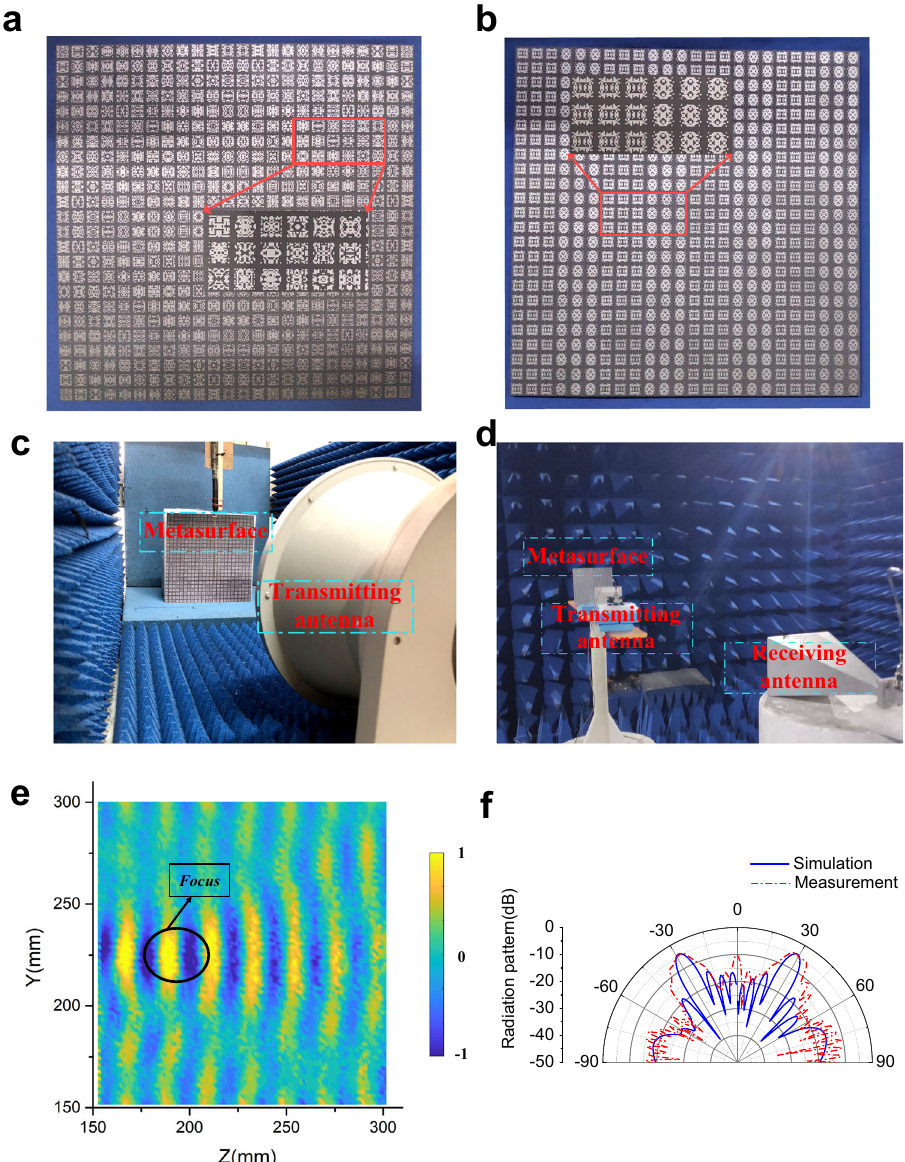
Fig. 6 Experimental veri fi cation of the metasurface. a Photograph of fabricated focusing metasurface prototype. b Photograph of fabricated abnormal re fl ection metasurface prototype. c Near- fi eld test environment of focusing. d Far- fi eld test environment of abnormal re fl ection. e The intensity of fi eld measured on YOZ plane. f The radiation pattern of abnormal re fl ection